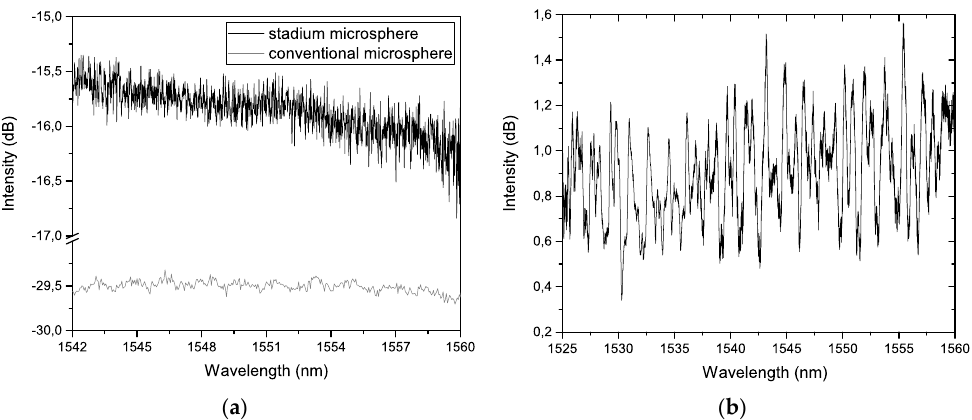
Figure 3. Reflection spectra of the stadium resonator ( a ) before and ( b ) after depositing the gold coating. In ( a ), the signal of a conventional microsphere is depicted for comparison (light plot). feedback (Figure 4). An IPG Photonics 1K ‐ C3 ‐ W erbium ‐ doped fiber amplifier (EDFA) was used as a